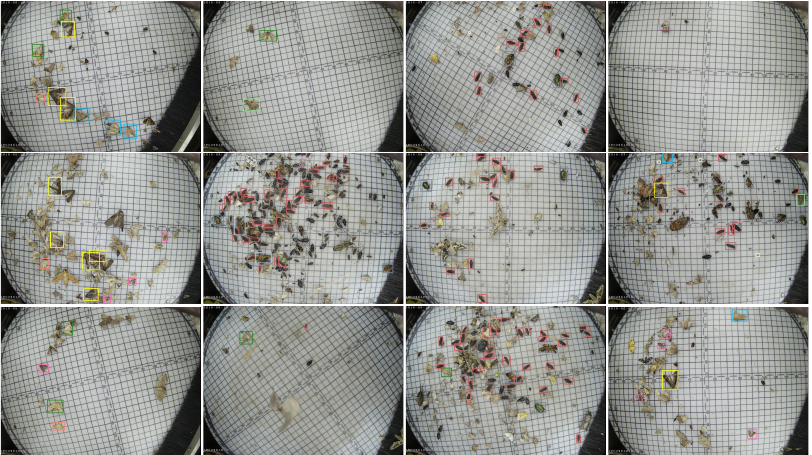
Figure 6. The samples of some ground truth boxes were labeled in the dataset, but not all the instances of the data are labeled in the dataset. There are many omissions in each image, resulting in a low MAP